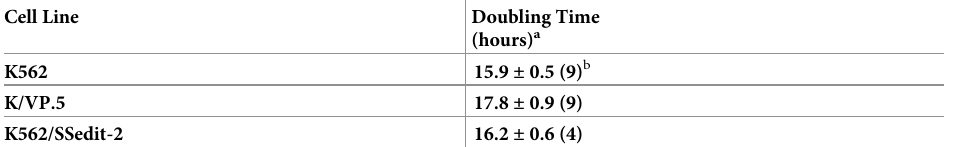
Table 2. Cell line growth characteristics.